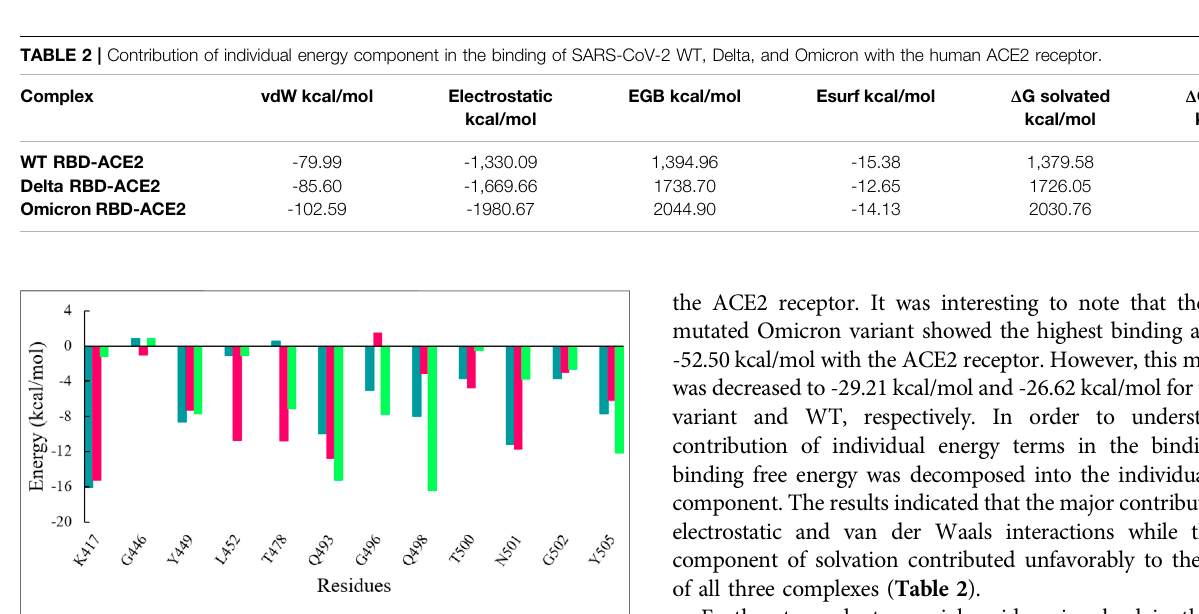
Frontiers in Chemistry |